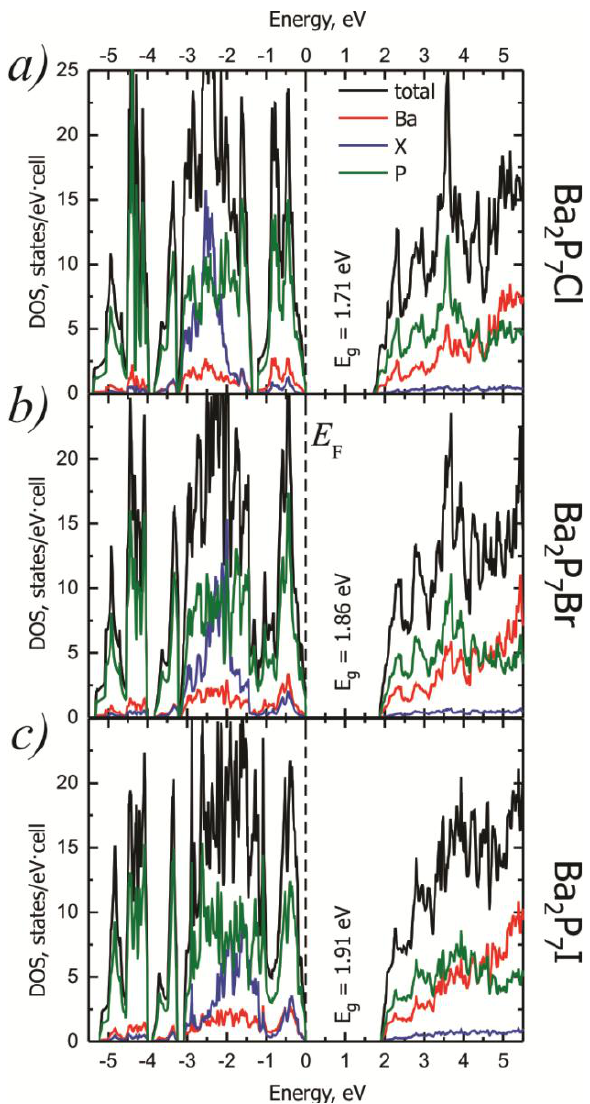
Figure 5. Density of states (DOS) diagram for Ba ( c ) X = I. Contributions from Ba, P, and X orbitals are shown in red, green, and blue colors,